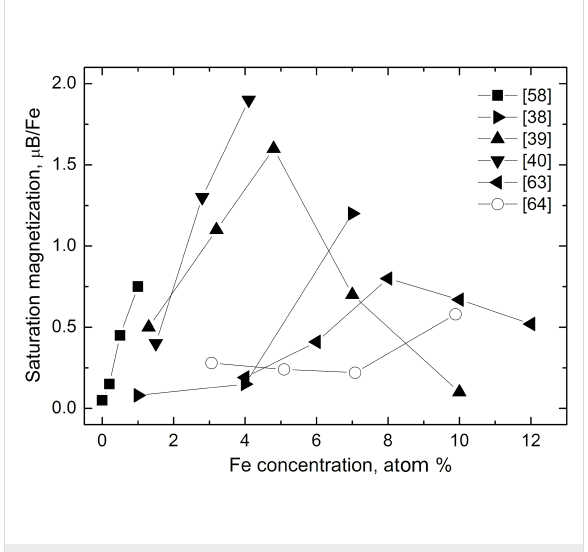
Figure 5: Dependence of the saturation magnetization (magnetic moment per iron atom in units of Bohr magnetons) on the Fe concen- tration in ZnO obtained by other methods such as magnetron sput- tering (filled right- [38], up- [39], down- [40] and left-triangles [63]), solid-state reaction (filled squares [58]) and mechanical alloying (open circles